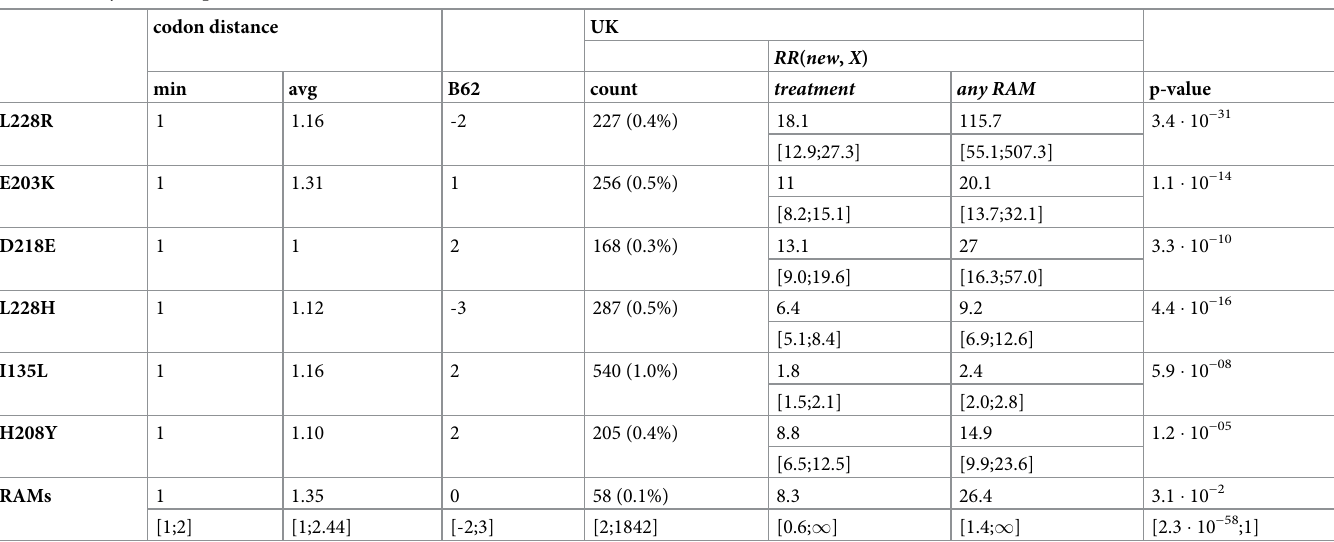
Table 3. Analysis of new potential RAMs. codon distance UK